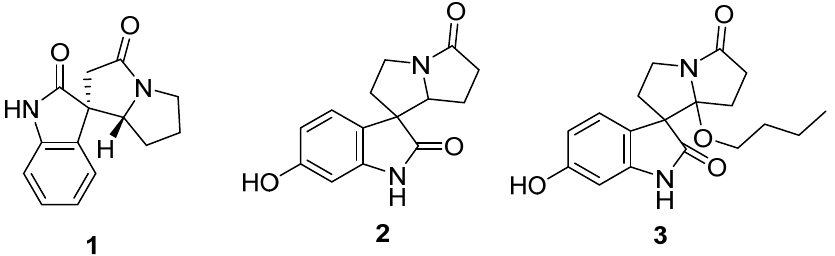
Figure 3. Flueindoline C 1 isolated from the ripe fruits of Flueggea virosa and spiroindoles 2 , 3 from Datura metel L . seeds.